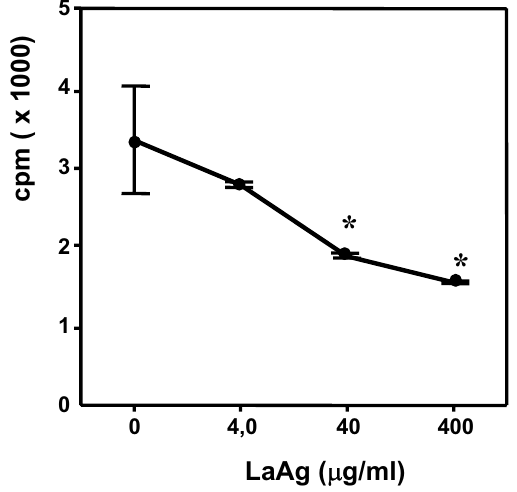
Fig. 5 – Effect of LaAg on antigen presentation. Peritoneal cells fromnormalBALB/cmicewereculturedat4 × 10 5 withLaAgat the indicated concentrations. Adherent cells were washed twice and then co-cultured for a further 72h with 2 × 10 5 immune T cells. Thecellproliferationwasexpressedascpm. Controlswere T cells incubated without adherent cells for the same time period: 301 ± 85 cpm. Mean ± SD (n=3). Asterisks indicate p ≤ 0 , 01 in relation to 0 µ